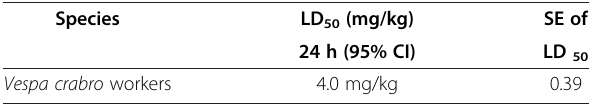
Table 2 Estimated 95% confidence interval for the LD 50 of hornet ’ s workers Vespa crabro L. and standard error (SE) of LD 50 Species LD 50